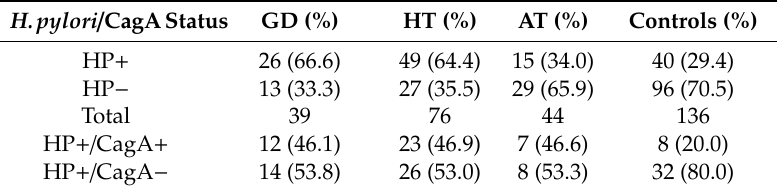
Table 1. Prevalence of overall H. pylori (HP) infection (%) and CagA status (%) in autoimmune Table 2. Fisher’s exact test p -value and odds ratio (OR) for determining prevalence of overall H. pylori thyroid diseases (AITDs) patients and controls. HP + , infected individuals; CagA + or CagA − , infected and CagA-positive H. pylori infection in patients with AITDs and controls. individuals with or without anti-CagA antibodies; GD, Grave’s disease; HT, Hashimoto’s thyroiditis; AT, aspecific thyroiditis. HP+ vs. HP −